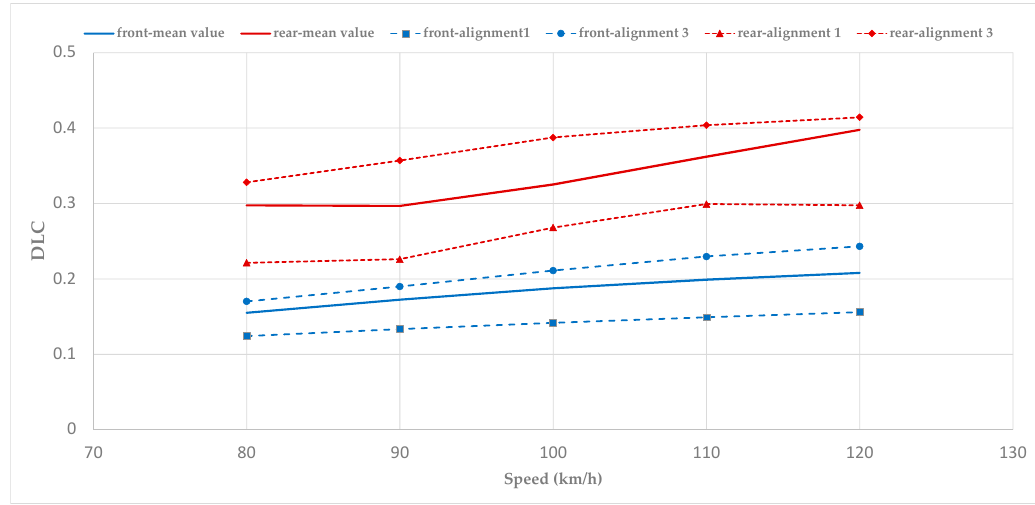
Figure 19. Front and rear axles dynamic load coefficient (DLC) values at different speeds.